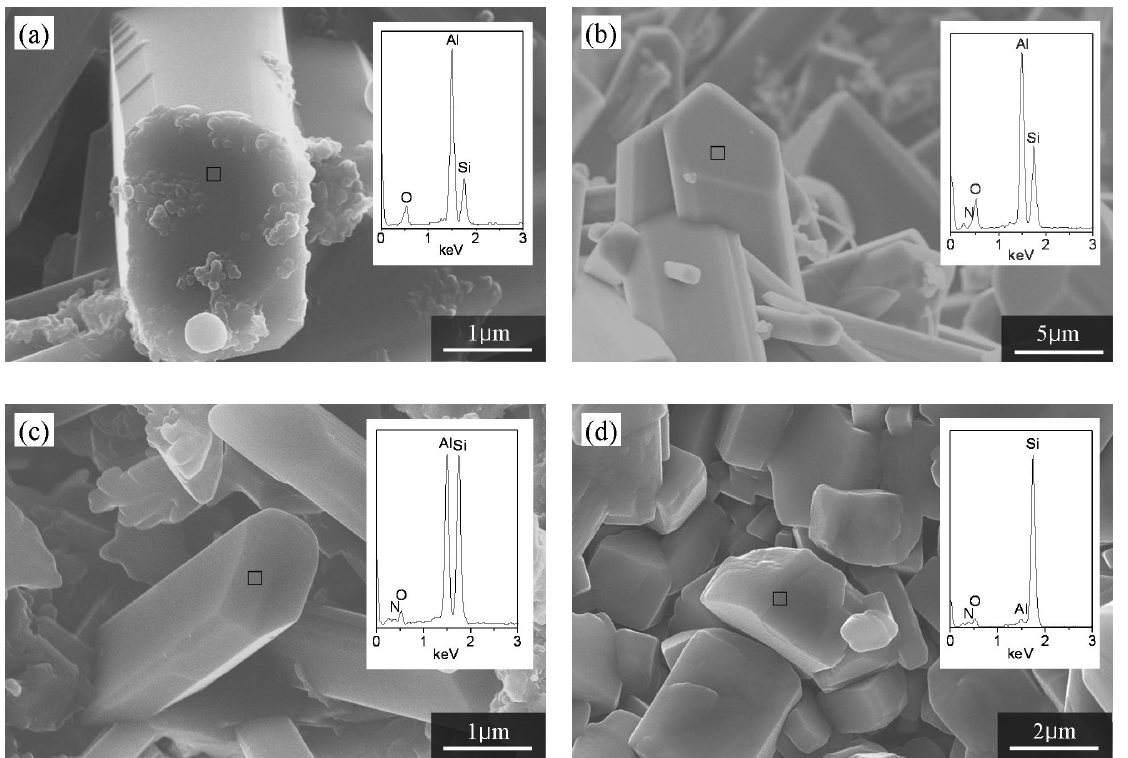
Figure 2. SEM images of fracture surfaces and EDS results of sample: ( a ) B1 (AC); ( b ) B2 (NA); ( c ) B3 (NC); ( d ) O 2